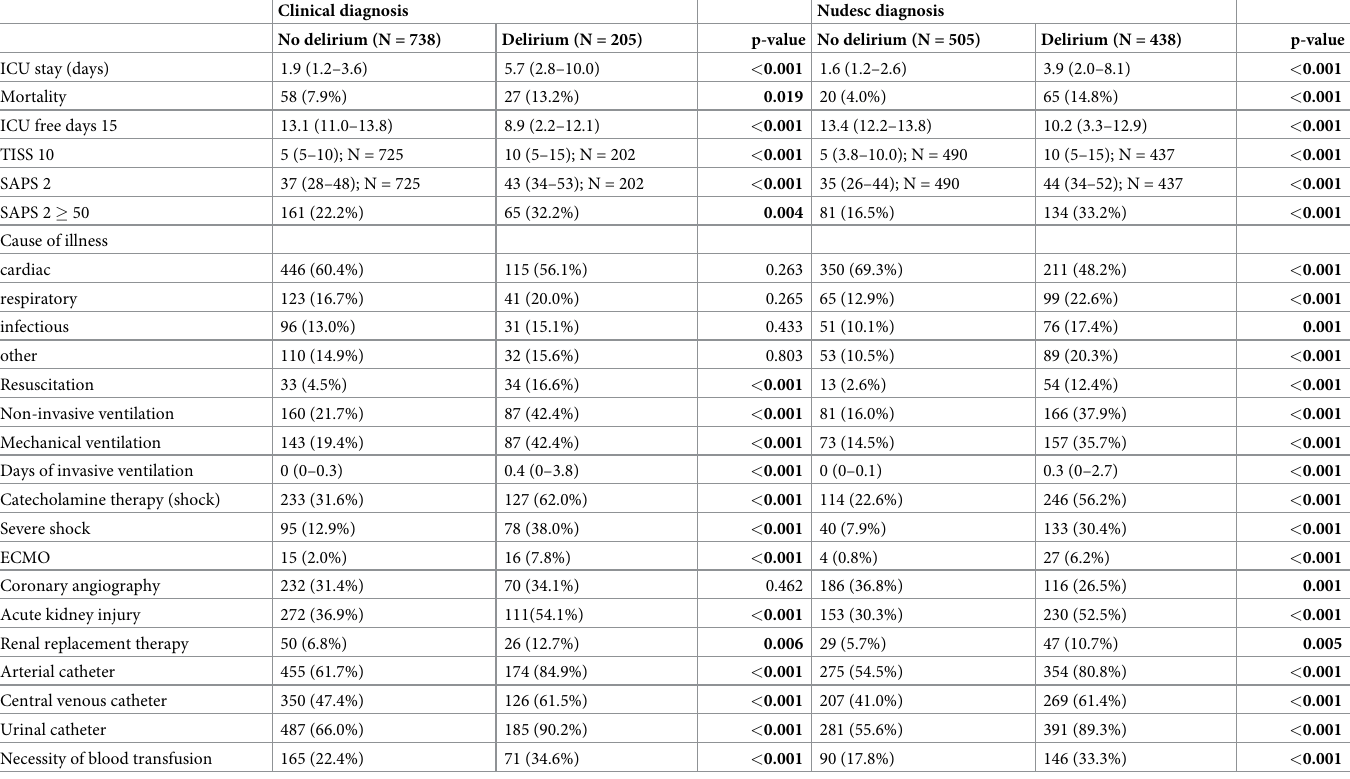
Table 2. Clinical characteristics of all